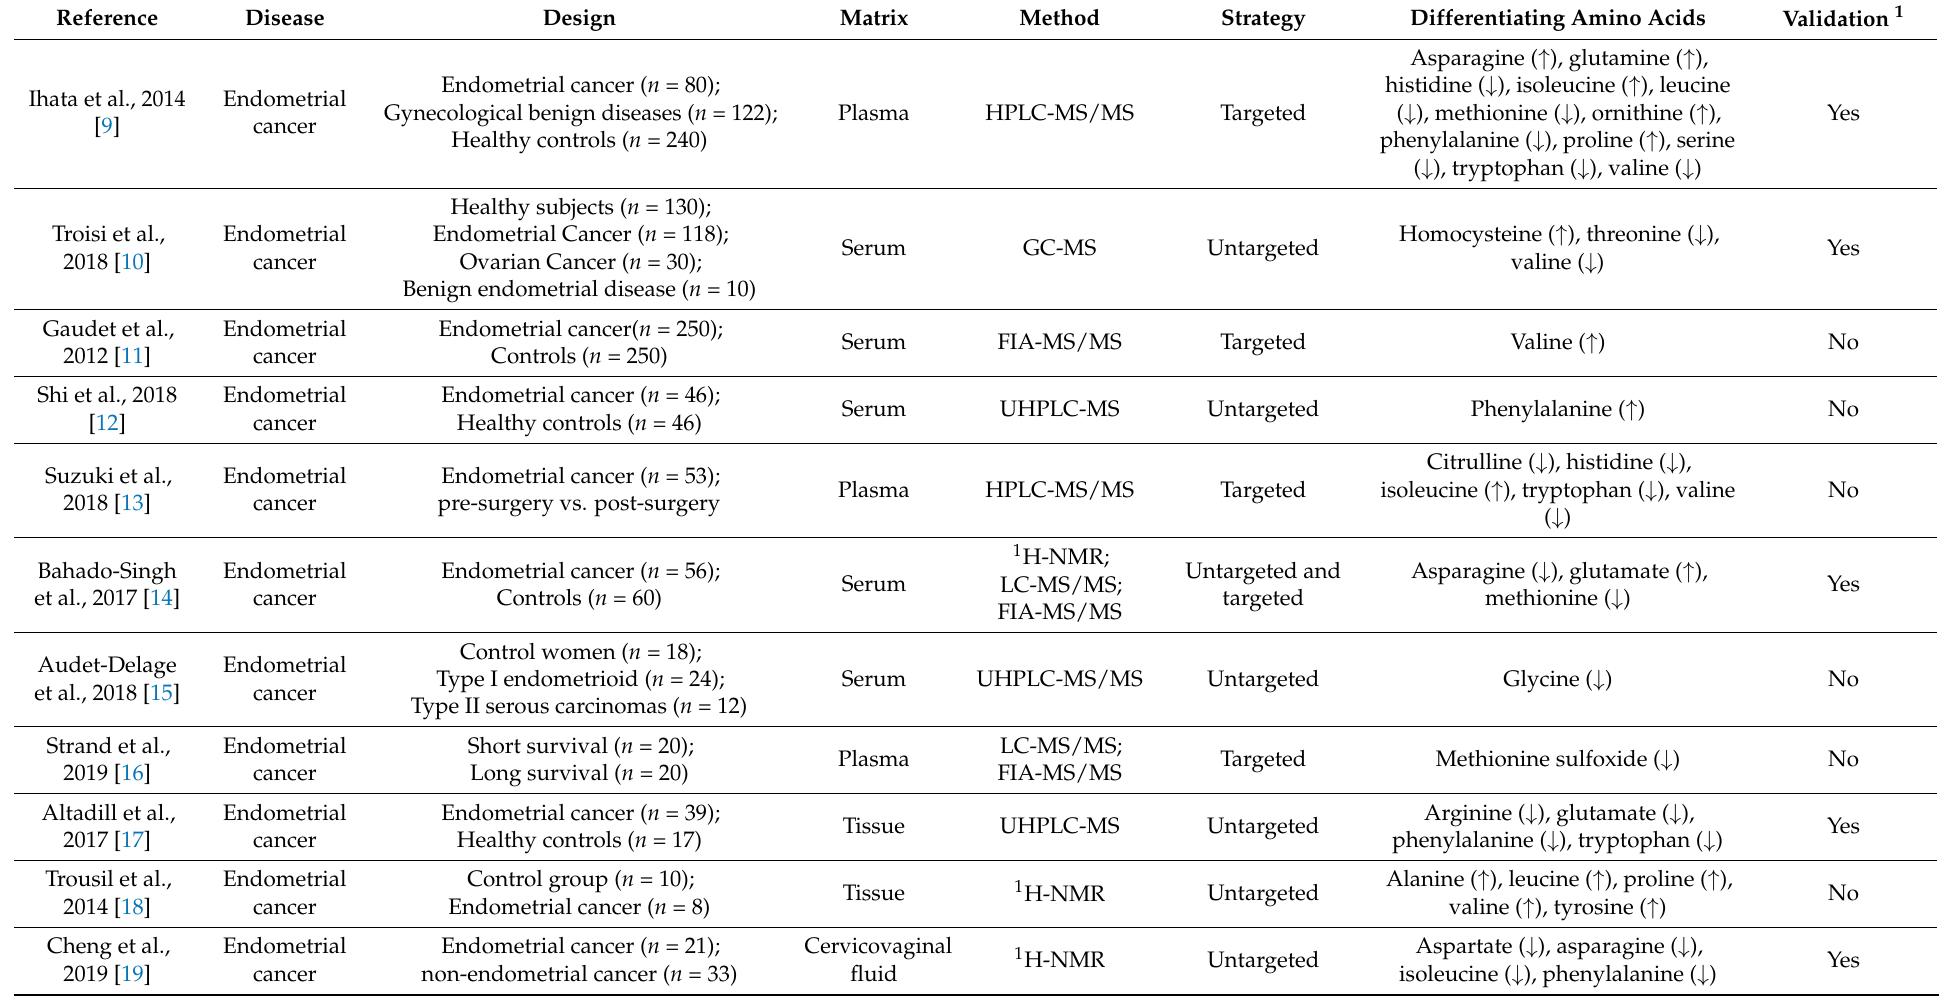
Table 1. Overview of metabolomic studies on endometrial, breast, ovarian, and cervical cancer and their